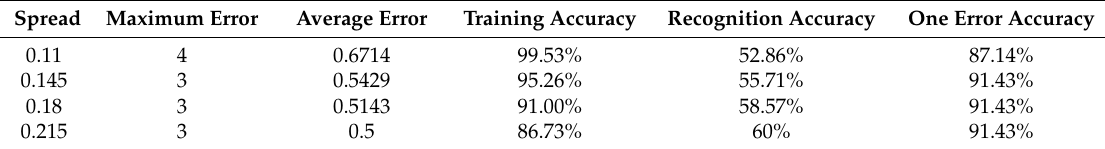
Table 3. Performance of the designed RBF neural network.